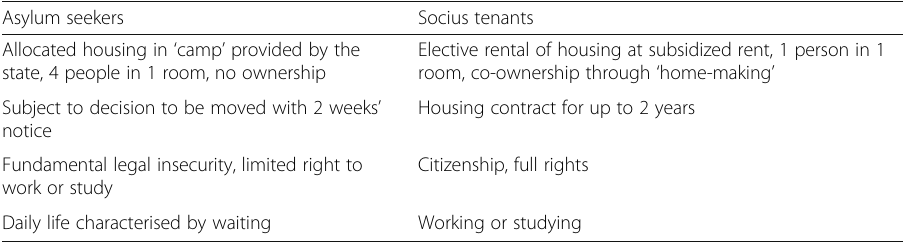
Table 1 Accommodation and conditions at Plan Einstein Asylum